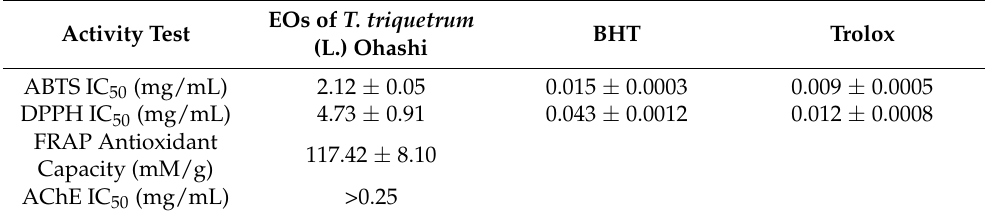
Table 2. T. triquetrum (L.) Ohashi IC 50 expression value of antioxidant activity and anticholinesterase activity test.